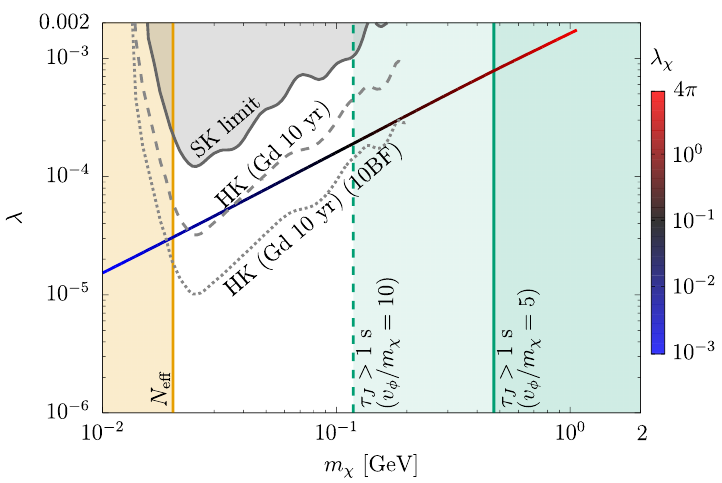
Figure 4 . Parameter space in the ( m χ , λ ) plane with m J /m χ = 0 . 1 . The gradient line from blue, black, and red represents the parameter space that can reproduce the observed dark matter relic abundance with the semi-annihilation χχ → χJ where the value of the quartic coupling λ χ required for dark matter core formation changes from 10 − 3 (blue) to 4 π (red). The orange region on the left-hand side is ruled out by N eff (freeze-out temperature . 1 MeV ). The green regions are excluded by the lifetime of the Majoron ( τ J > 1 s ) for a fixed v φ /m χ = 5 , 10 . The gray region is also excluded by the SK data [34]. The dashed and dotted gray lines represent the HK sensitivity using Gd 10 years and without/with a boost factor of 10 (10BF) at the galaxies compared with the value required for the relic abundance [36].